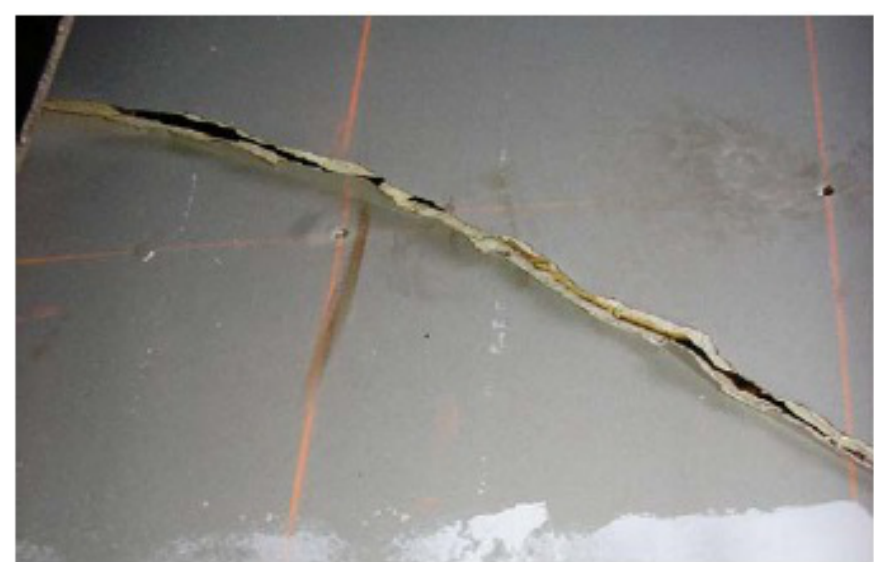
Figure 19. Tension failure of gypsum wallboard.